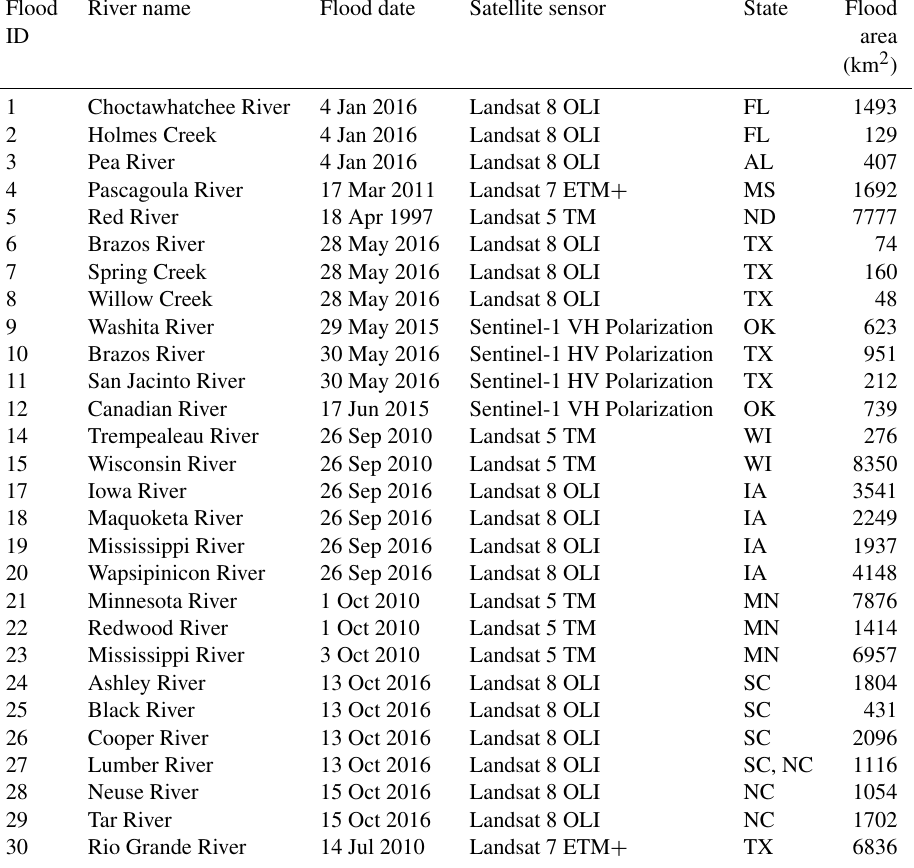
Table A1. Flood events used for